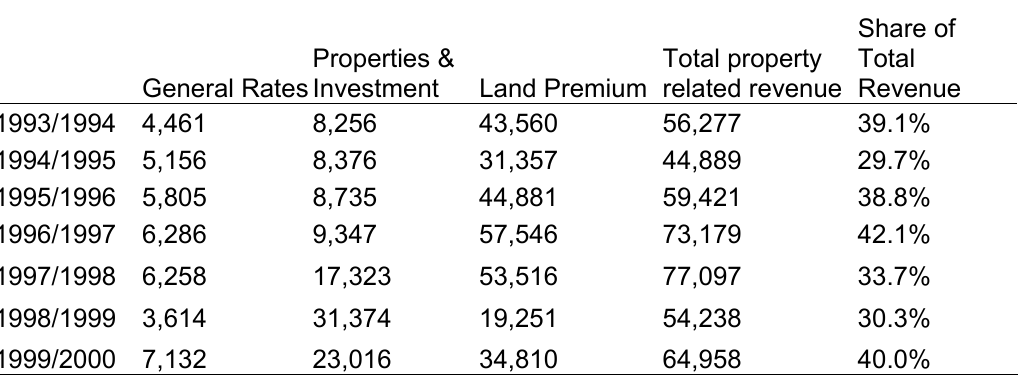
Table 3. Government revenue from property-related sources (In million HK